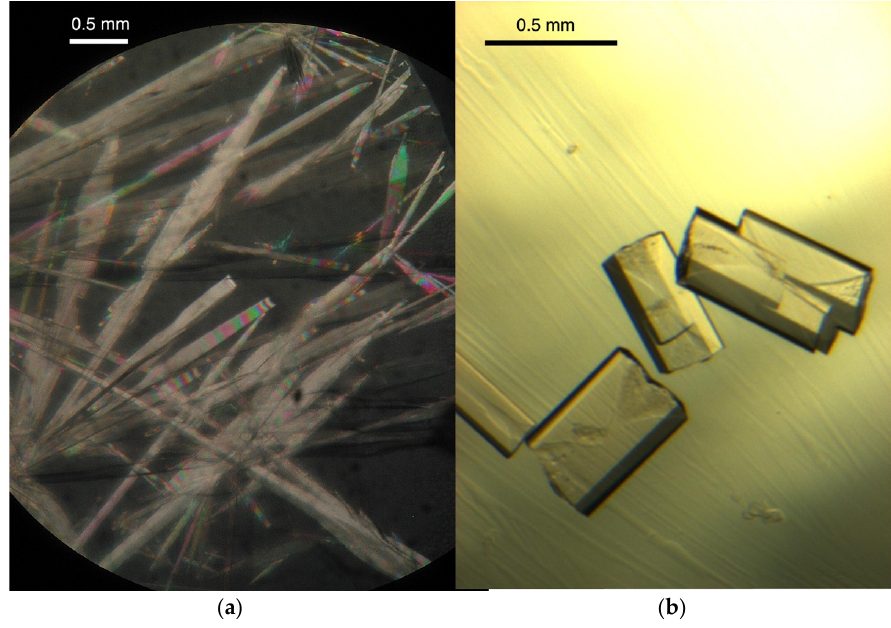
Figure 1. Crystals of the dodeca-nucleotide B-DNA ( a ) and of the hexa-nucleotide Z-DNA ( b ).